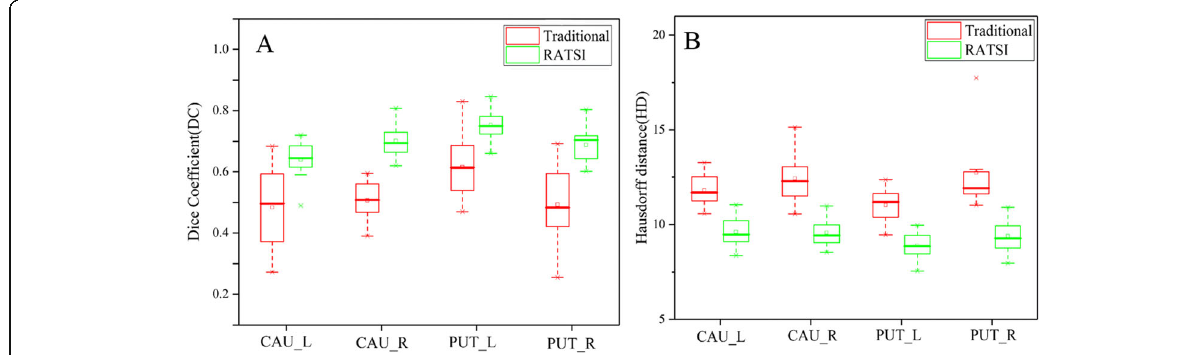
Fig. 3 The boxplots displaying distributions of the Dice coefficient ( a ) and Hausdorff distance ( b ), which were used to evaluate the brain segmentation accuracy in compared with the ground truth, the manual segmentation results. The red and green boxplots represented the results of RSIAT method and RATSI, respectively. Representative nuclei including caudate nucleus (left: CAU_L, right: CAU_R) and putamen (left: PUT_L, right: PUT_R) were segmented for